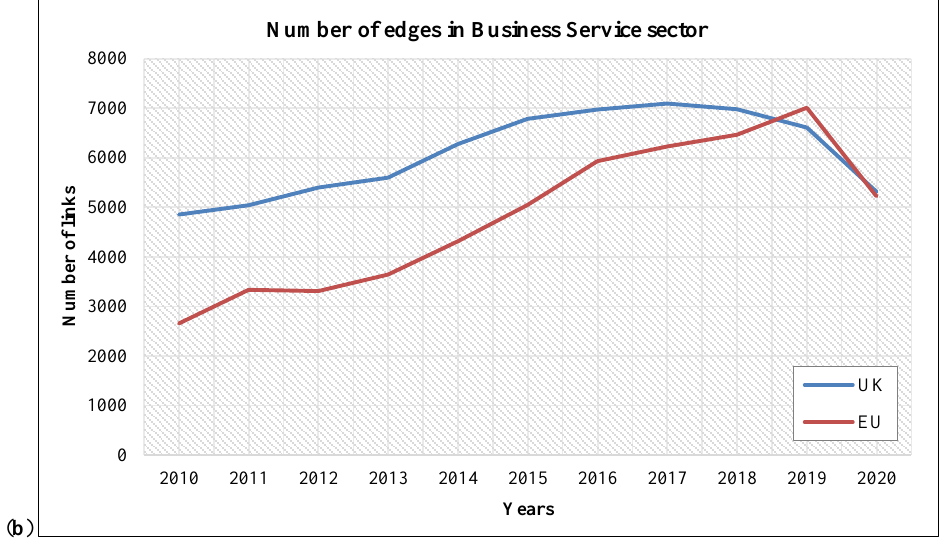
Figure 8. Comparison Analysis for the Number of Edges: (a) Analysis for the Number of Edges in the Consumer Service Sector; (b) Analysis for the Number of Edges in the Business Service Sector